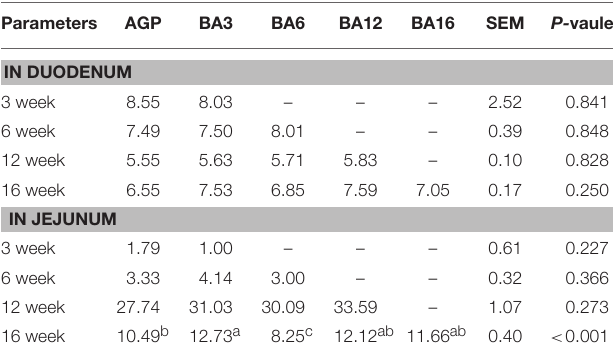
TABLE 6 | The sIgA content in the duodenum and jejunum mucosa of pullets fed on different dietary treatments from 0 to 16 weeks (ng/100mg protein). Parameters